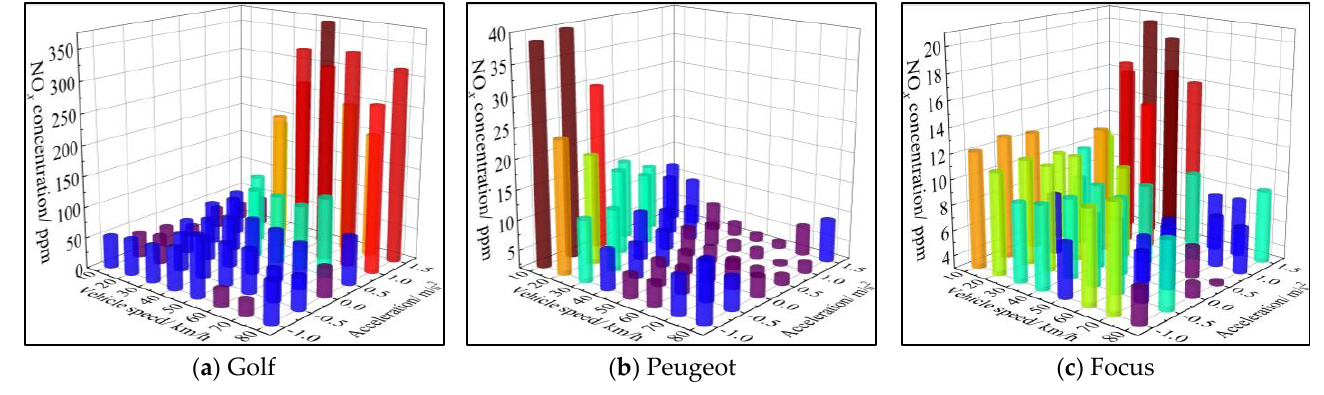
Figure 8. NO x concentration vs. vehicle speed and acceleration. The influence of engine speed and torque on NO x concentration is shown in Figure